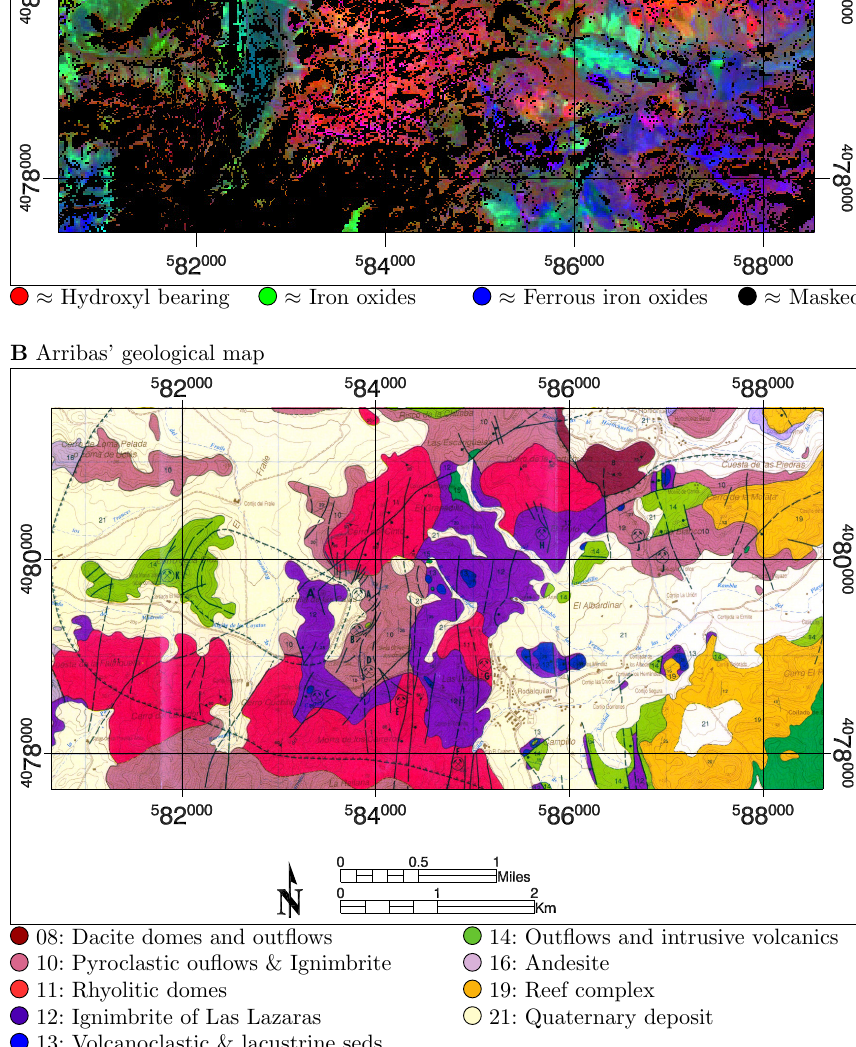
Figure 8. A colour composite made with Sentinel-2A MSI ( A ) consisting of band ratios TM 5/7 in red, 3/1 in green and 3/5 in blue. The patterns show a similarity with the volcanic rock units in the Rodalquilar area in a subset of a published geological map [50] ( B